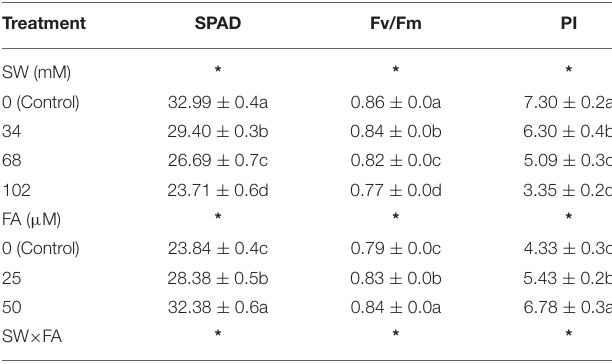
TABLE 2 | The effect of SW irrigation and FA spraying on SPAD, Fv/Fm, and PI of Plectranthus amboinicus plants grown under greenhouse conditions. Treatment